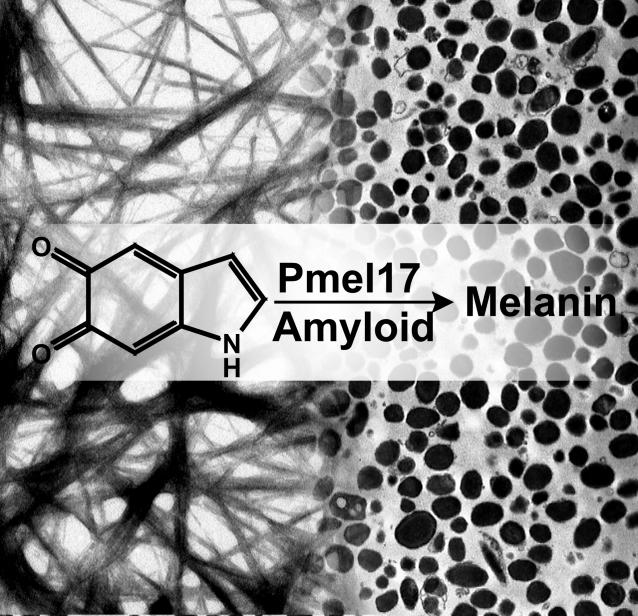
A native, nontoxic mammalian amyloid structure, generated by the protein Pmel17, helps accelerate synthesis of melanin